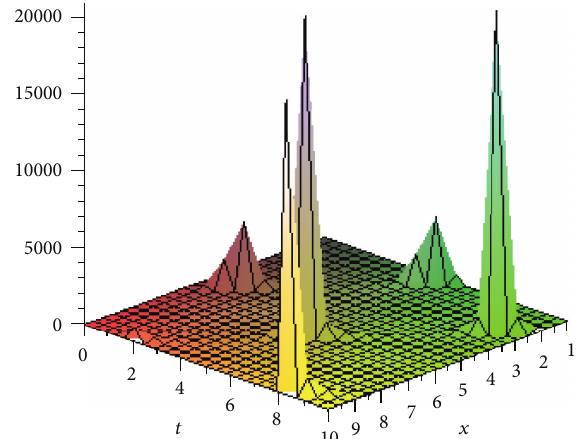
Figure 5: The solution 𝑉 4 in (36) with 𝛾 = 4/5 , 𝑘 = 𝑐 = 𝜎 = 𝑏 2 = = 1 , 𝜇 = 1 , 𝜉 𝑓 2